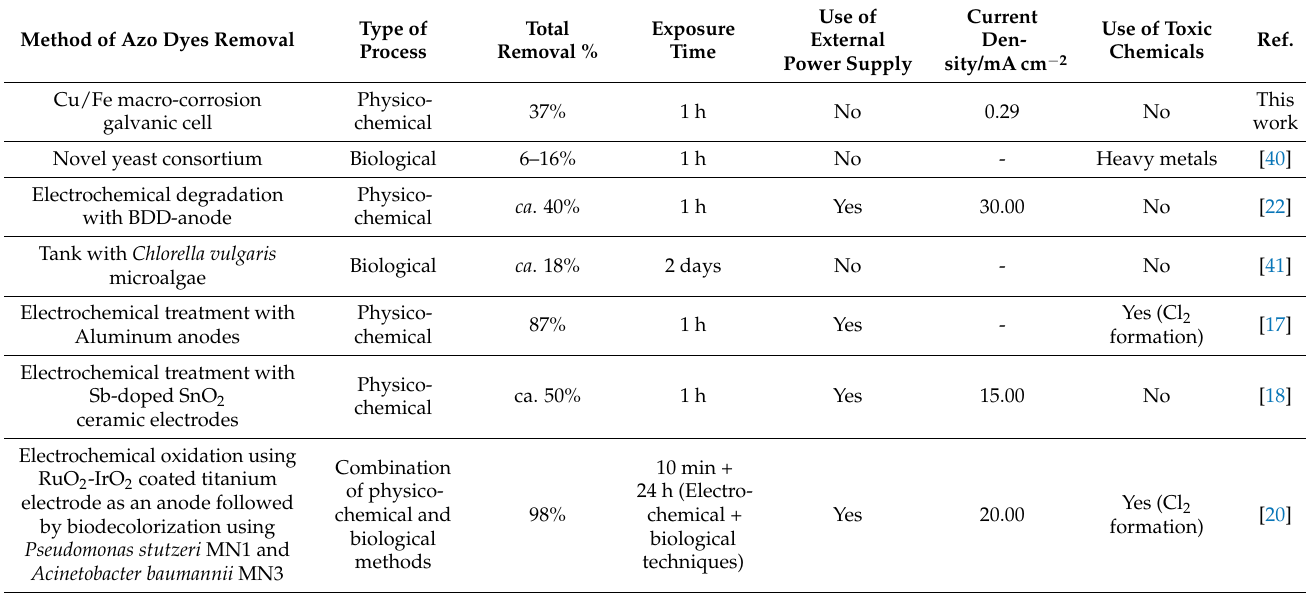
Table 2. Efficiency comparison and features of various novel azo dyes removal methods.